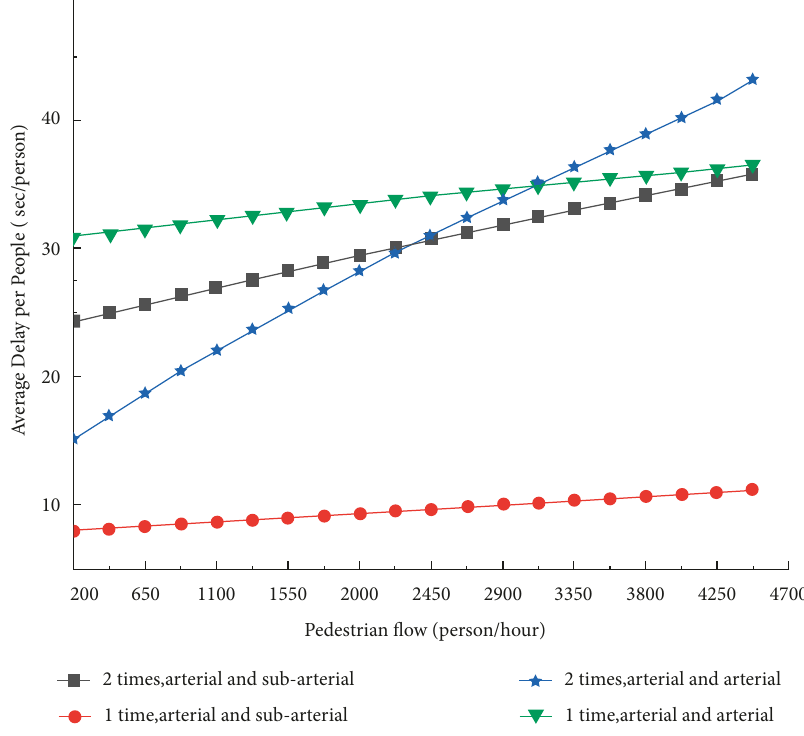
Figure 12: Variation trend of average delay per